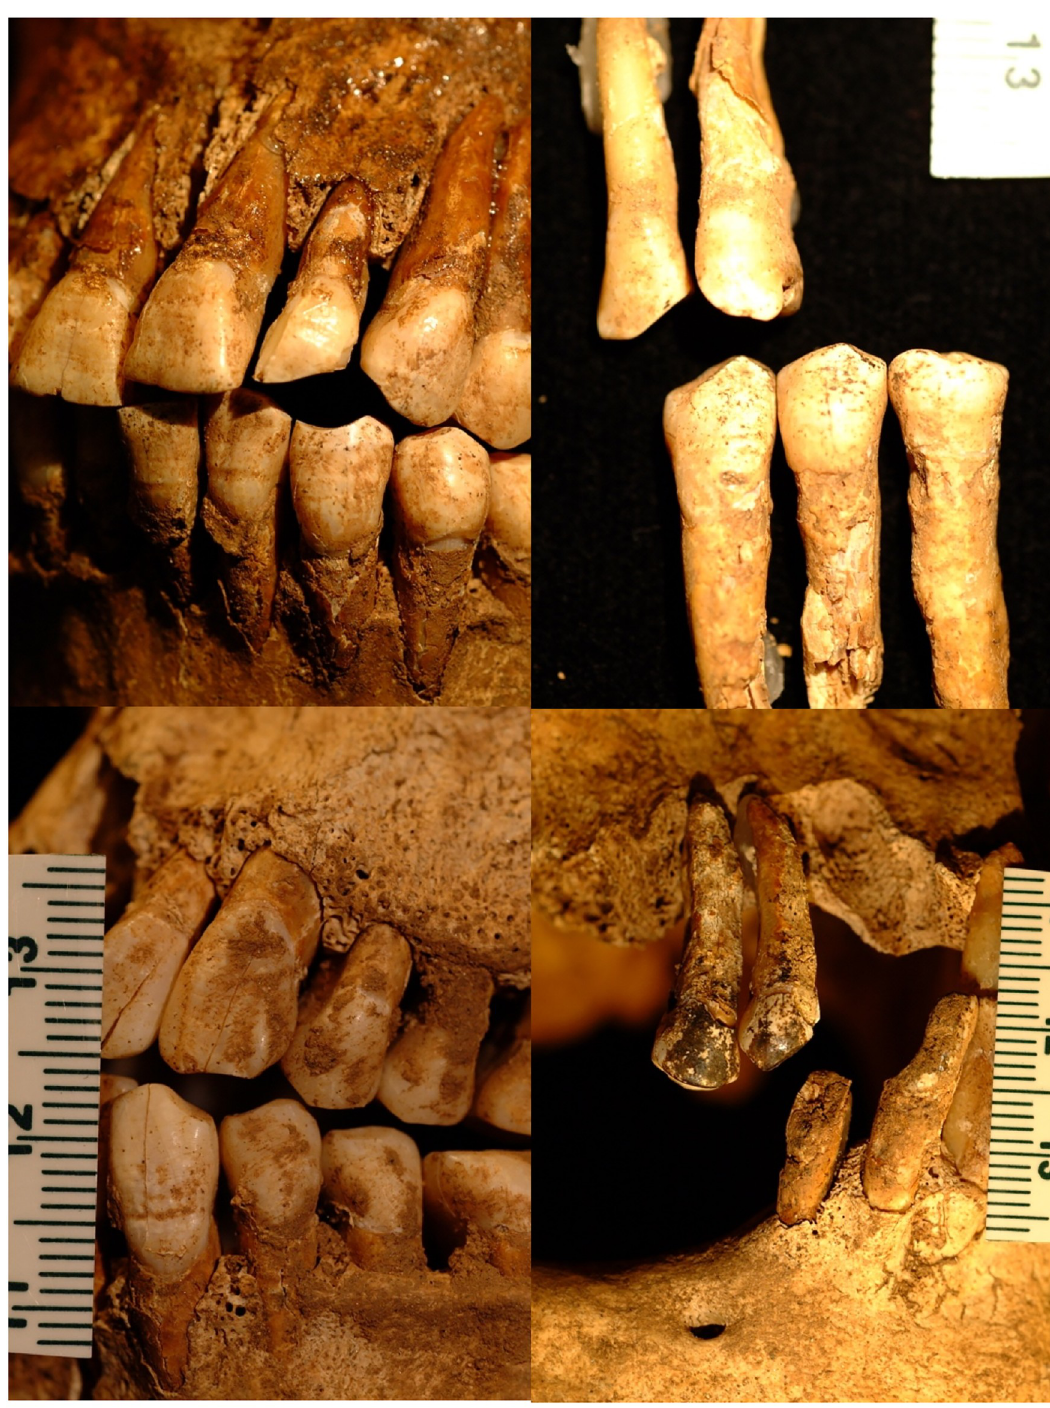
Fig 11. Dental wear resulting from habitual pipe smoking. Clockwise from top left: YNH4 A, B, B2, B3. Scale in mm.